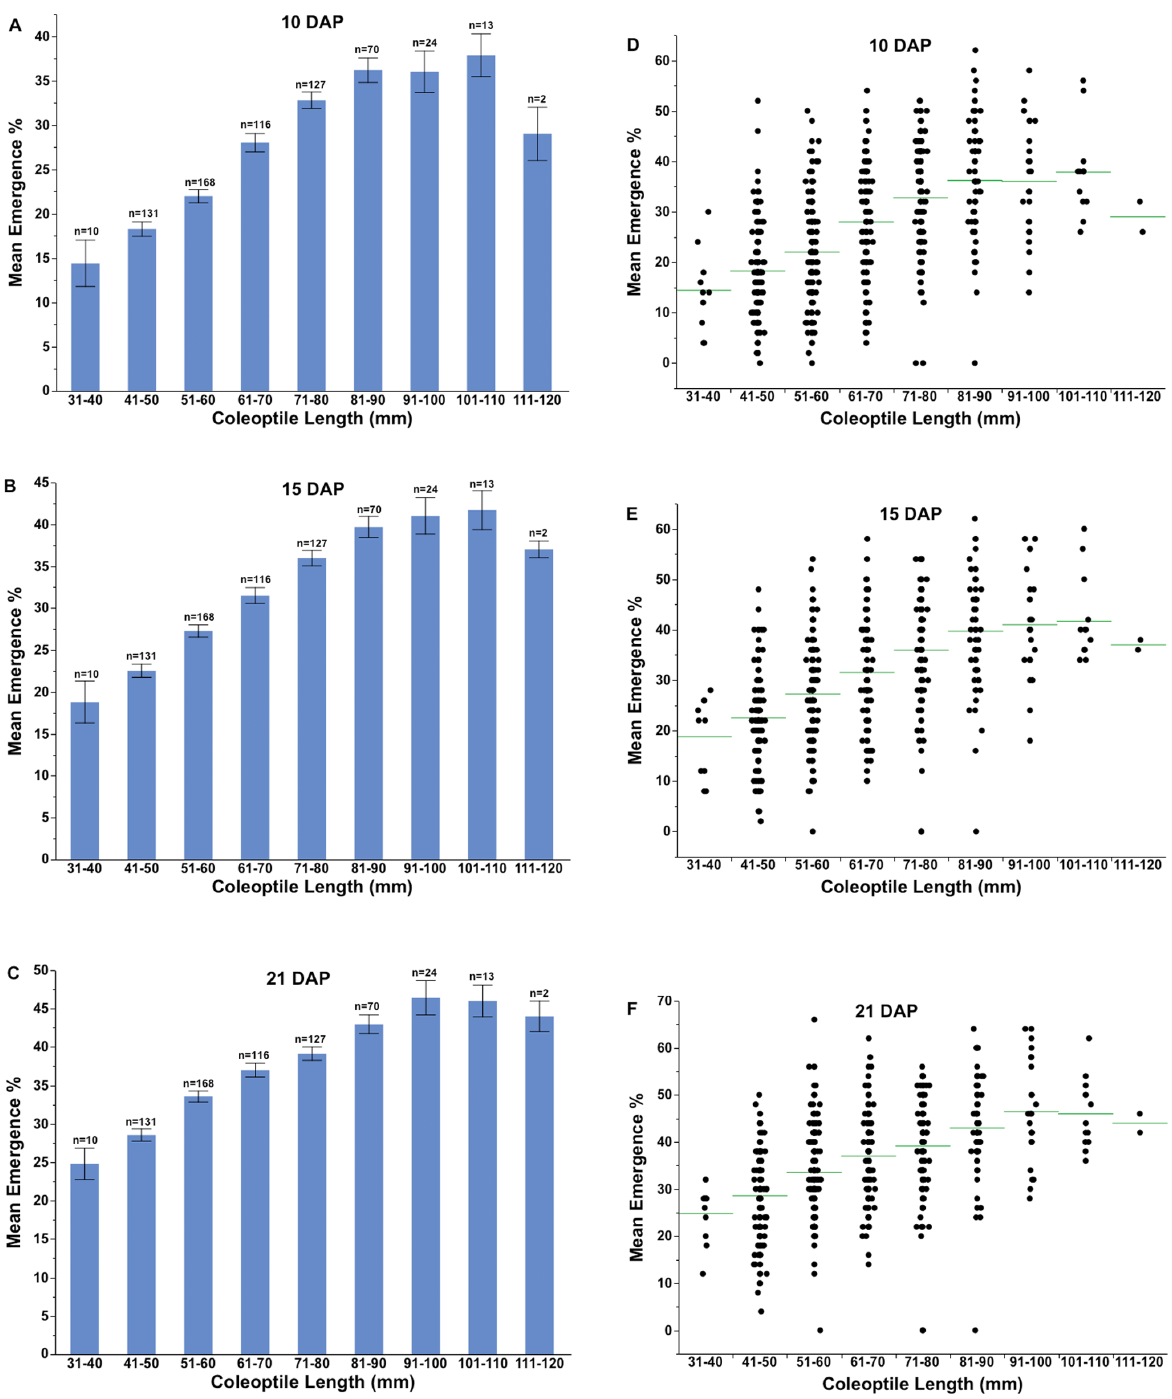
Figure 2. Mean emergence percentage among various coleoptile length classes (A–C) and, range of variation in coleoptile length classes on 10, 15, and 21 days after planting (D–F). The error bar represents the standard error of the mean. Number of lines in each coleoptile length class (n) is given above each bar. The horizontal line represents the mean in each coleoptile class (D–F). doi:10.1371/journal.pone.0073314.g002 length than to emergence speed (Figure 2E–F). Except for the four improvements occurred for the three shortest coleoptile classes (31–40, 41–50, and 51–60 mm) and then leveled off for the next non-emerging entries that spanned four coleoptile length classes with the highest being 80 to 90 mm, minimum emergence in each four classes (Figure 2D–F). Maximum emergence for the two coleoptile length class gradually increased with the increasing longest coleoptile length classes gradually decreased from 64% in coleoptile length (Figure 2D–F). The greatest relative emergence